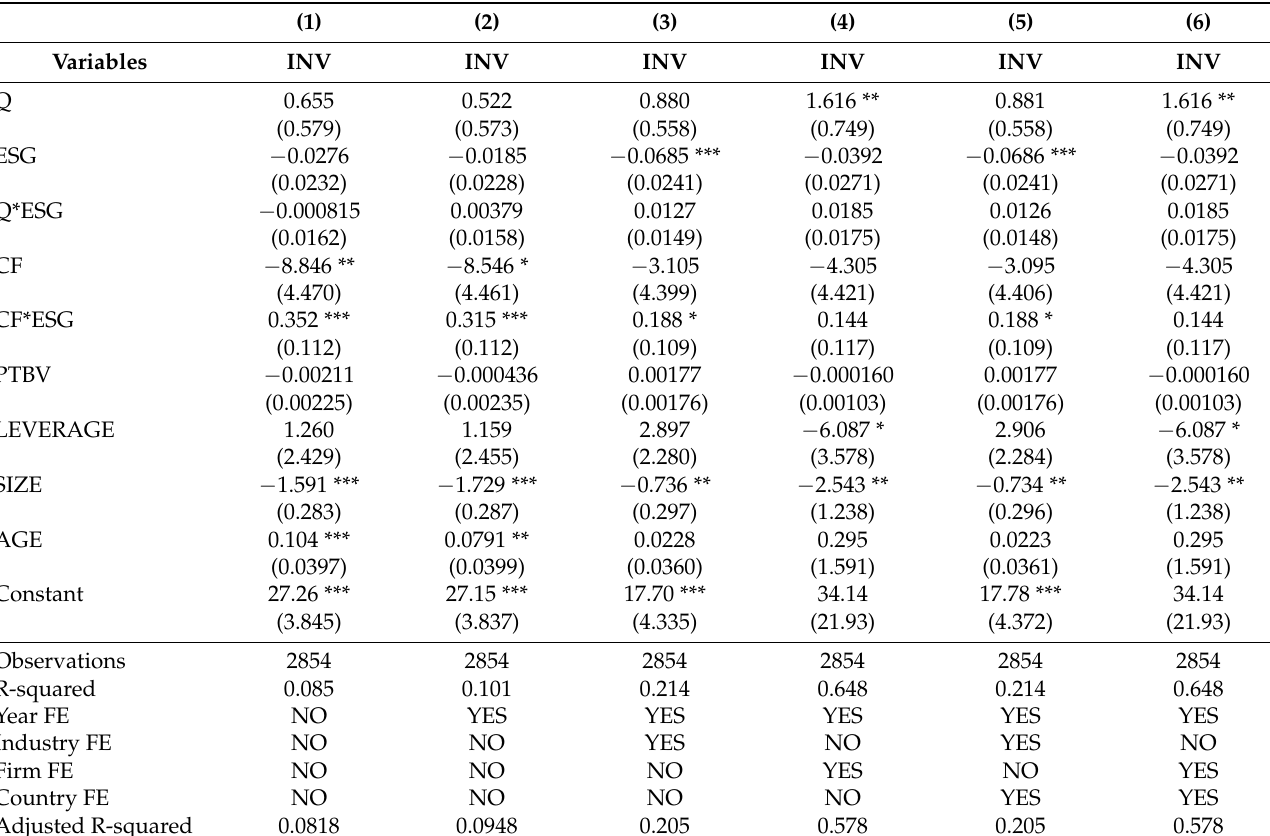
Table 2. The overall ESG performance and investment